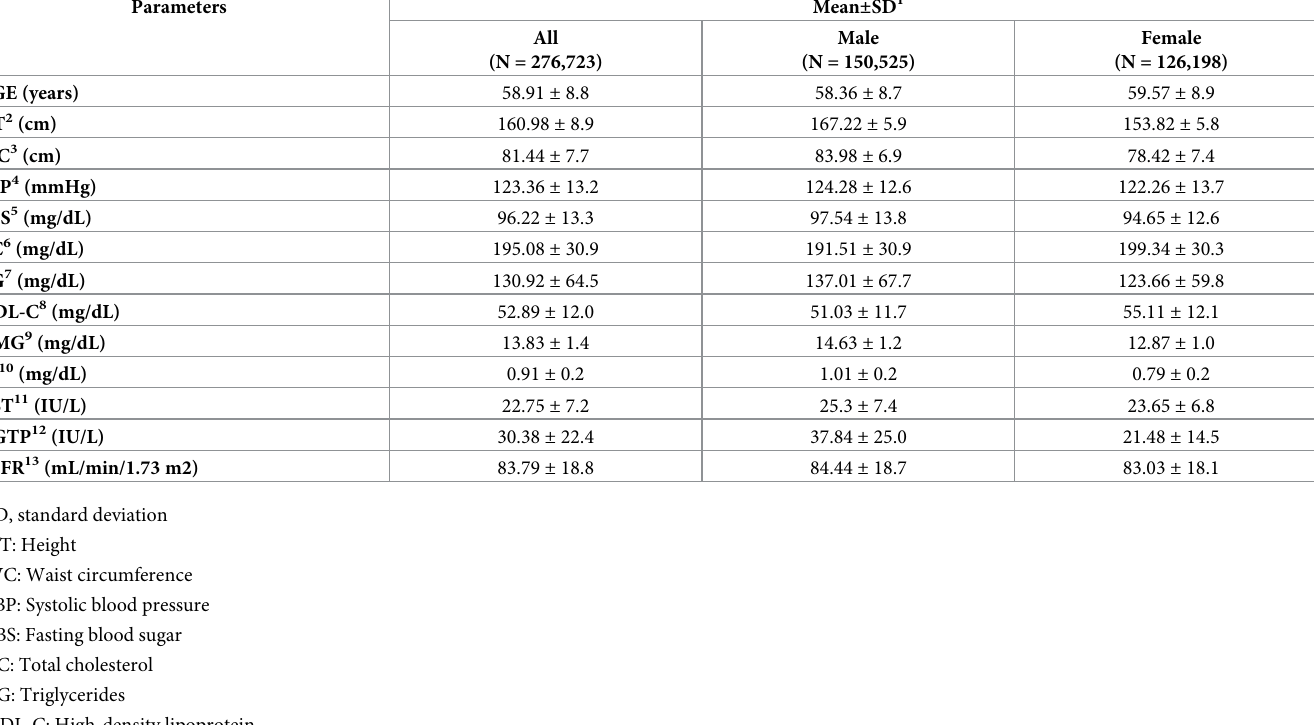
Table 2. General characteristics of the